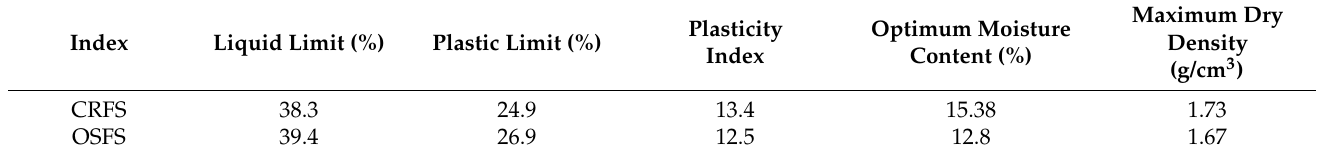
Table 1. Physical properties of the two modified soils.